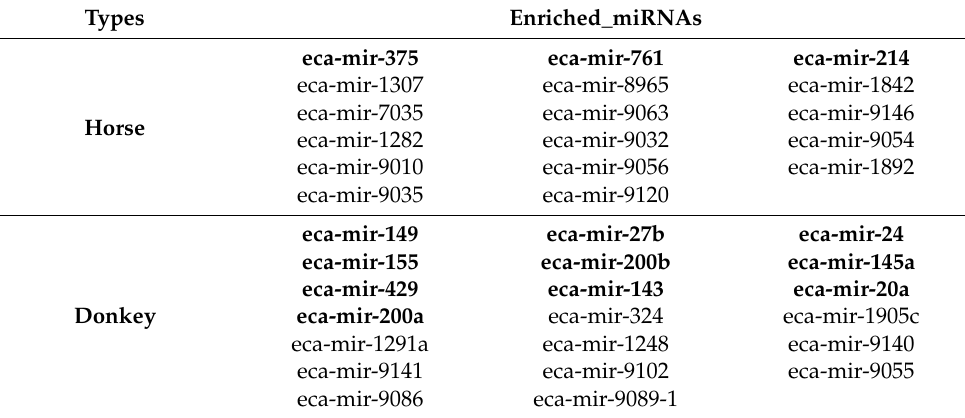
Table 2. Annotation of enriched-miRNAs in horse testis tissue and donkey testis